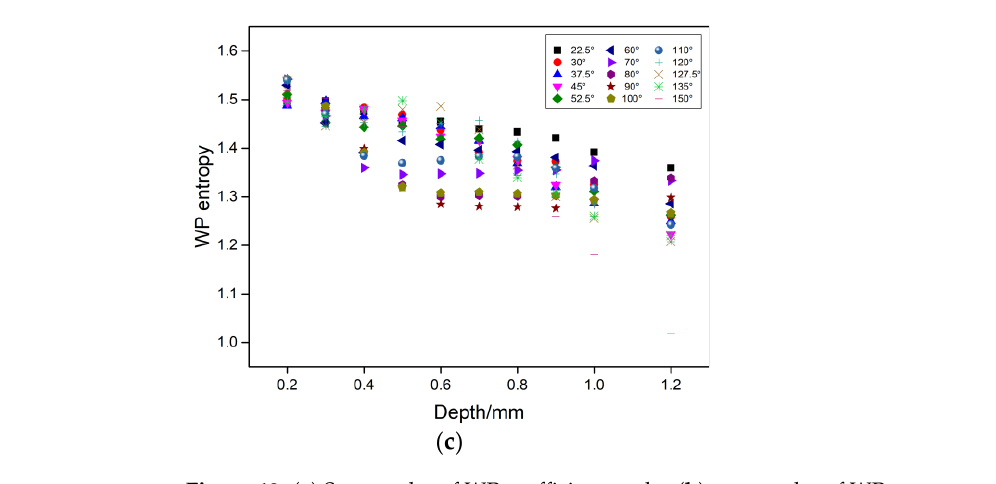
Figure 12. ( a ) Scatter plot of WP coefficient peaks; ( b ) scatter plot of WP energy peaks; ( c ) scatter plot of WP entropy.